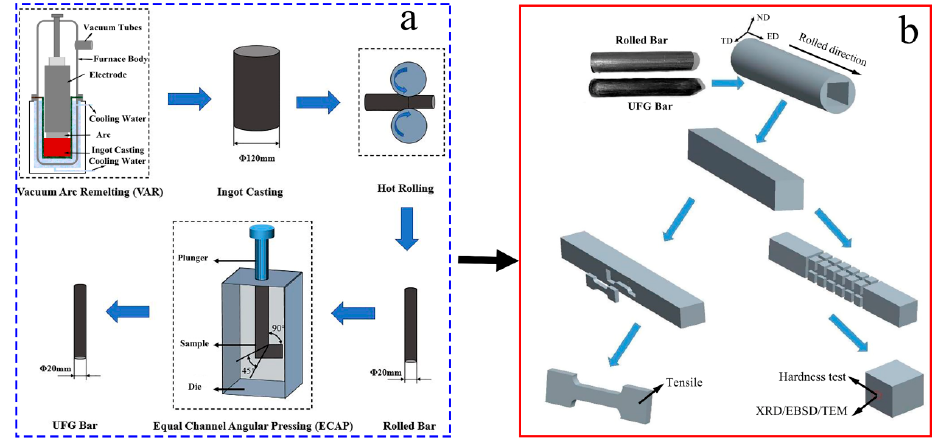
Figure 1. Schematic illustration of ( a ) the processing routes and ( b ) sample-selected plane for tests. To investigate the influence of the annealing temperature (AT) on the mechanical properties and microstructures of the UFG TiFeB alloy, the isochronal and isothermal treatments were performed. Isochronal annealing was conducted at various temperatures from 150 °C to 750 °C with holding for one hour, and isothermal annealing was performed at temperatures from 350 °C to 750 °C with different holding times (15 min–150 min). Air cooling was used after annealing.